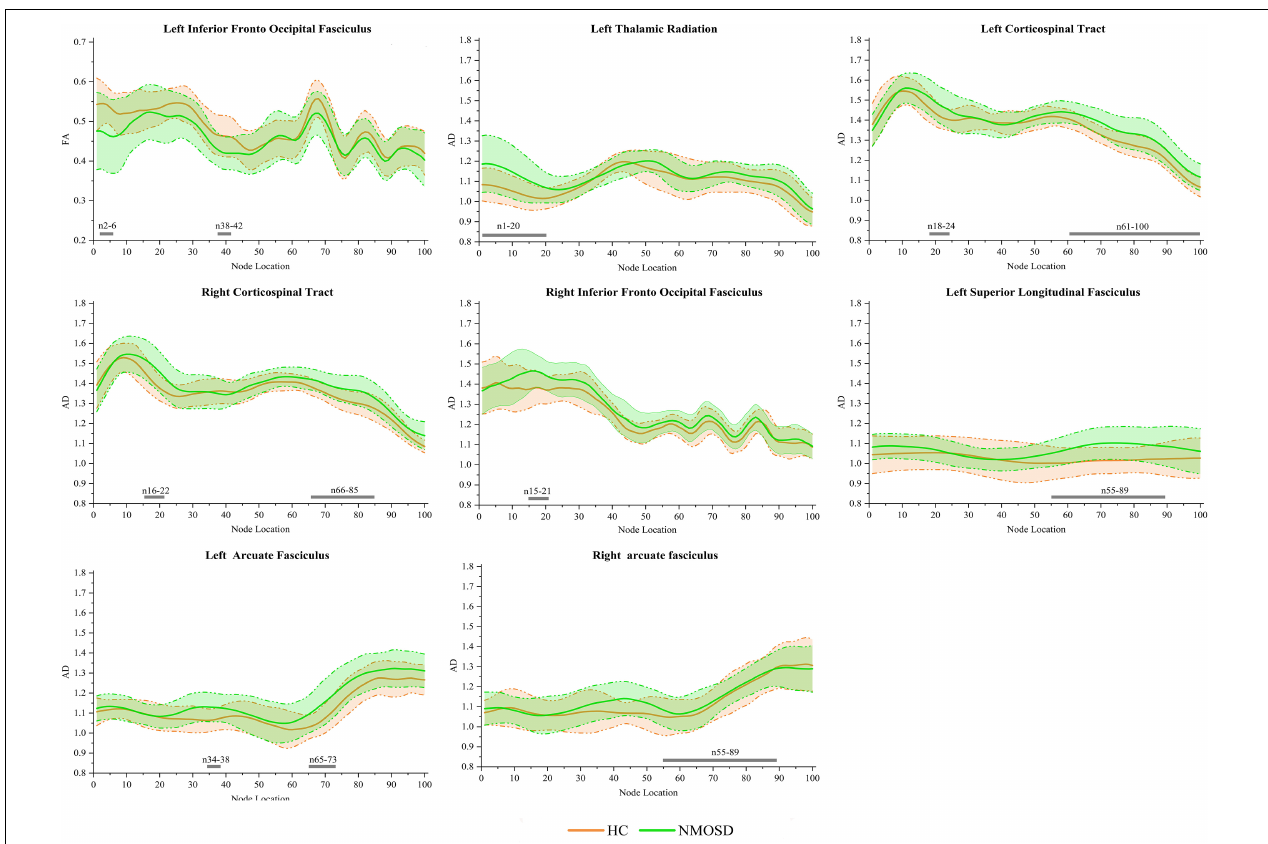
FIGURE 3 | Group differences in pointwise white matter (WM) fiber tracts of fractional anisotropy (FA) and axial diffusivity (AD) between neuromyelitis optica spectrum disorder (NMOSD) and healthy controls [HCs; p < 0.05, false discovery rate (FDR) correction]. The green line represents the NMOSD group, and the orange line represents the HC group [solid lines for means and shaded regions for standard deviations (SDs)]. The gray bars at the bottom are the location of the fiber nodes with significant differences between the two